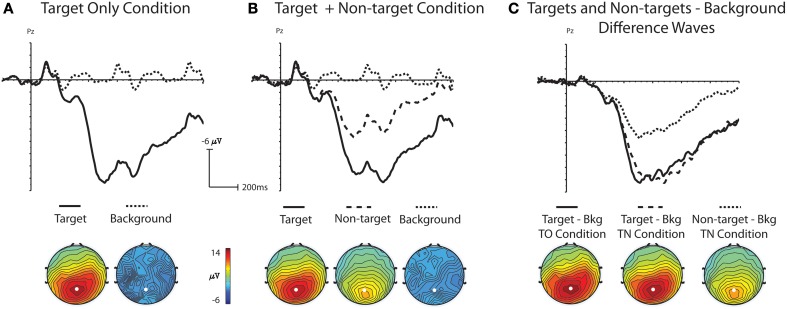
Grand-average ERP waveforms at electrode Pz and topographic voltage maps (400–800 ms); white dot indicates location of electrode Pz. (A) Shows grand-average ERP waveforms and topographic maps to target and background distractor stimuli in the Target Only (TO) condition. (B) Shows grand-average ERP waveforms and topographic maps to target, non-target and background distractor stimuli in the Target plus Non-target (TN) condition. (C) Shows difference waves created by subtracting the background distractor from targets in the TO condition and the background distractor from targets and non-targets in the TN condition.